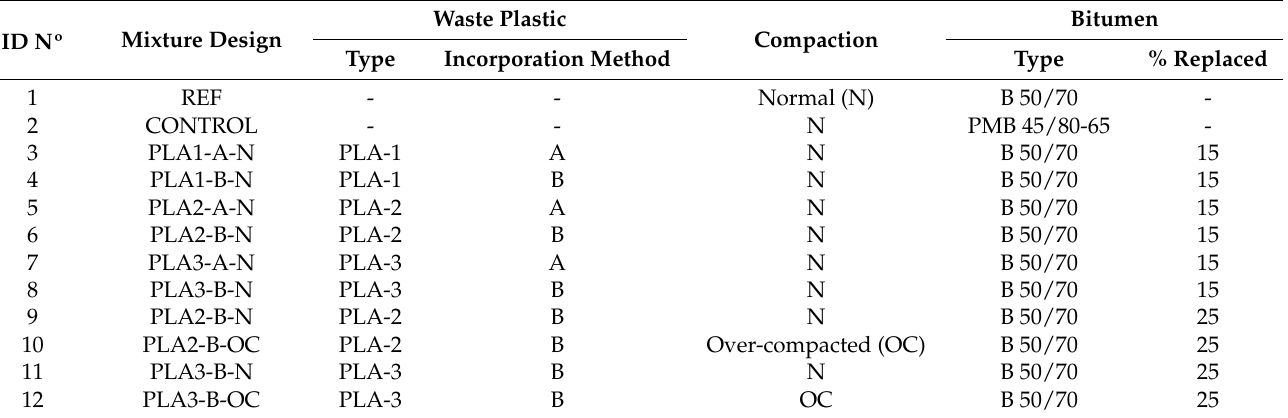
Table 3. Asphalt concrete mixture